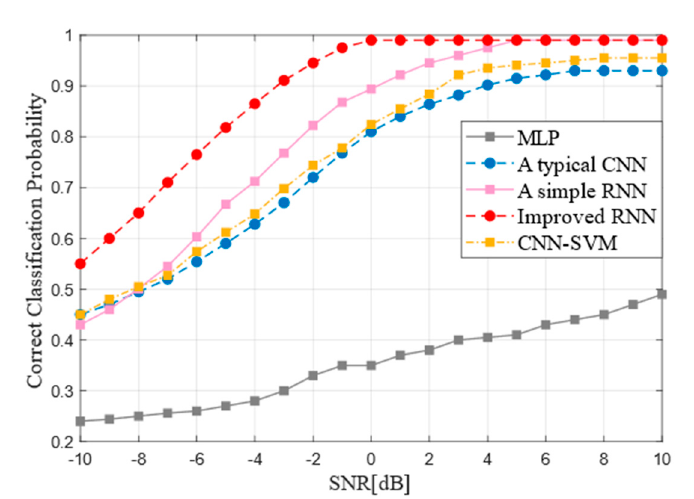
Figure 10. Performance comparison of the improved RNN with others.